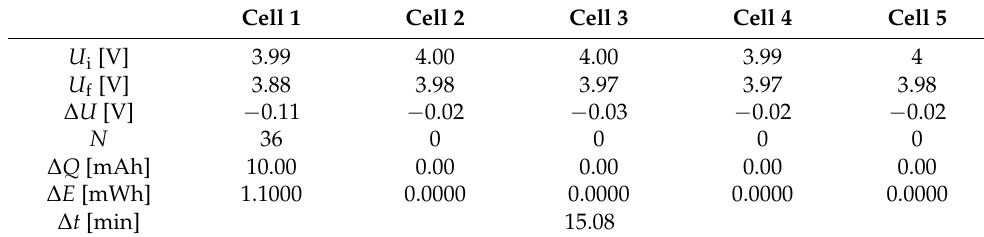
Table 5. De-balance system configuration data.